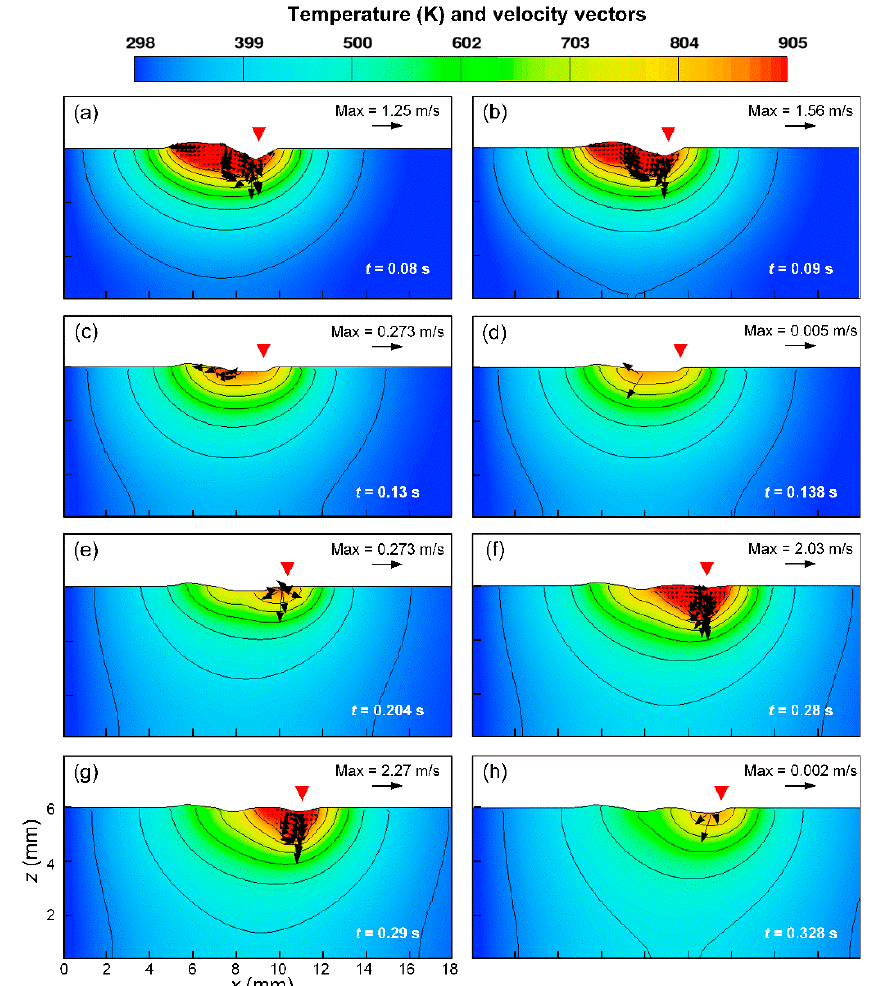
Figure 7. Longitudinal views of temperature and velocity distributions at ( a ) t = 0.08 s, ( b ) 0.09 s, ( c ) 0.13 s, ( d ) 0.138 s, ( e ) 0.204 s, ( f ) 0.28 s, ( g ) 0.29 s, and ( h ) 0.328 s.